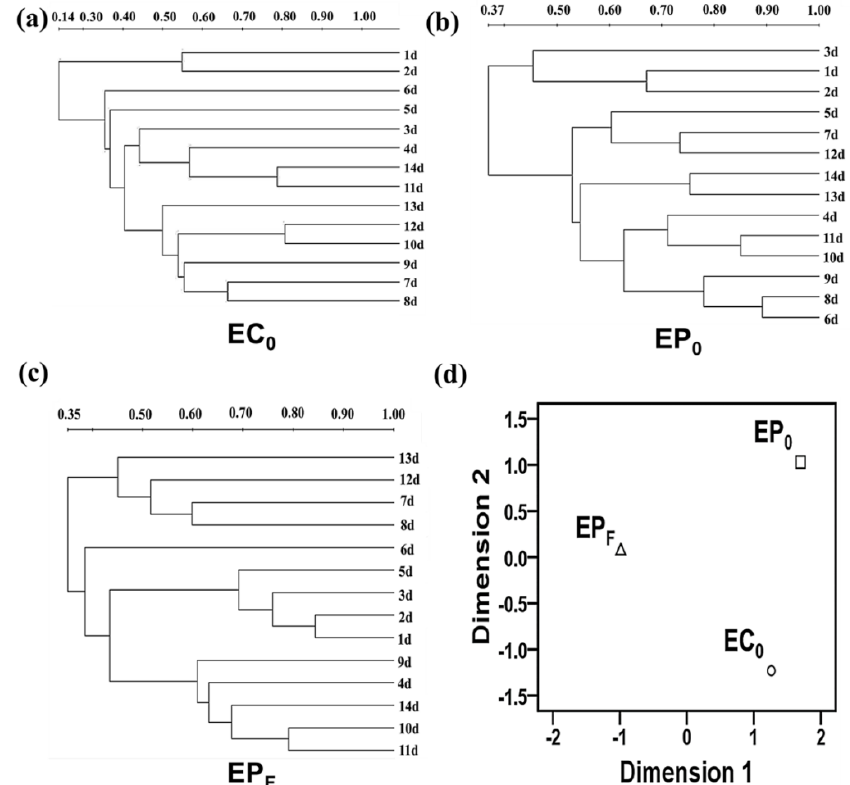
Figure 5. Clustering pattern of pioneer biofilm-forming eukaryotic communities formed on the C0, P 0 and P F surfaces. ( a–c ) the clustering patterns of pioneer biofilm-forming the eukaryotic communities adhering to the C 0 , P 0 and P F surfaces (EC 0 , EP 0 and EP F ) based on the Unweighted Pair-Group Method with Arithmetic means (UPGMA) method. ( d ) the multidimensional scale (MDS) analysis of the clustering patterns of the early pioneer eukaryotic communities (EC 0 , EP 0 and EP F ) on the C 0 , P 0 and P F surfaces.